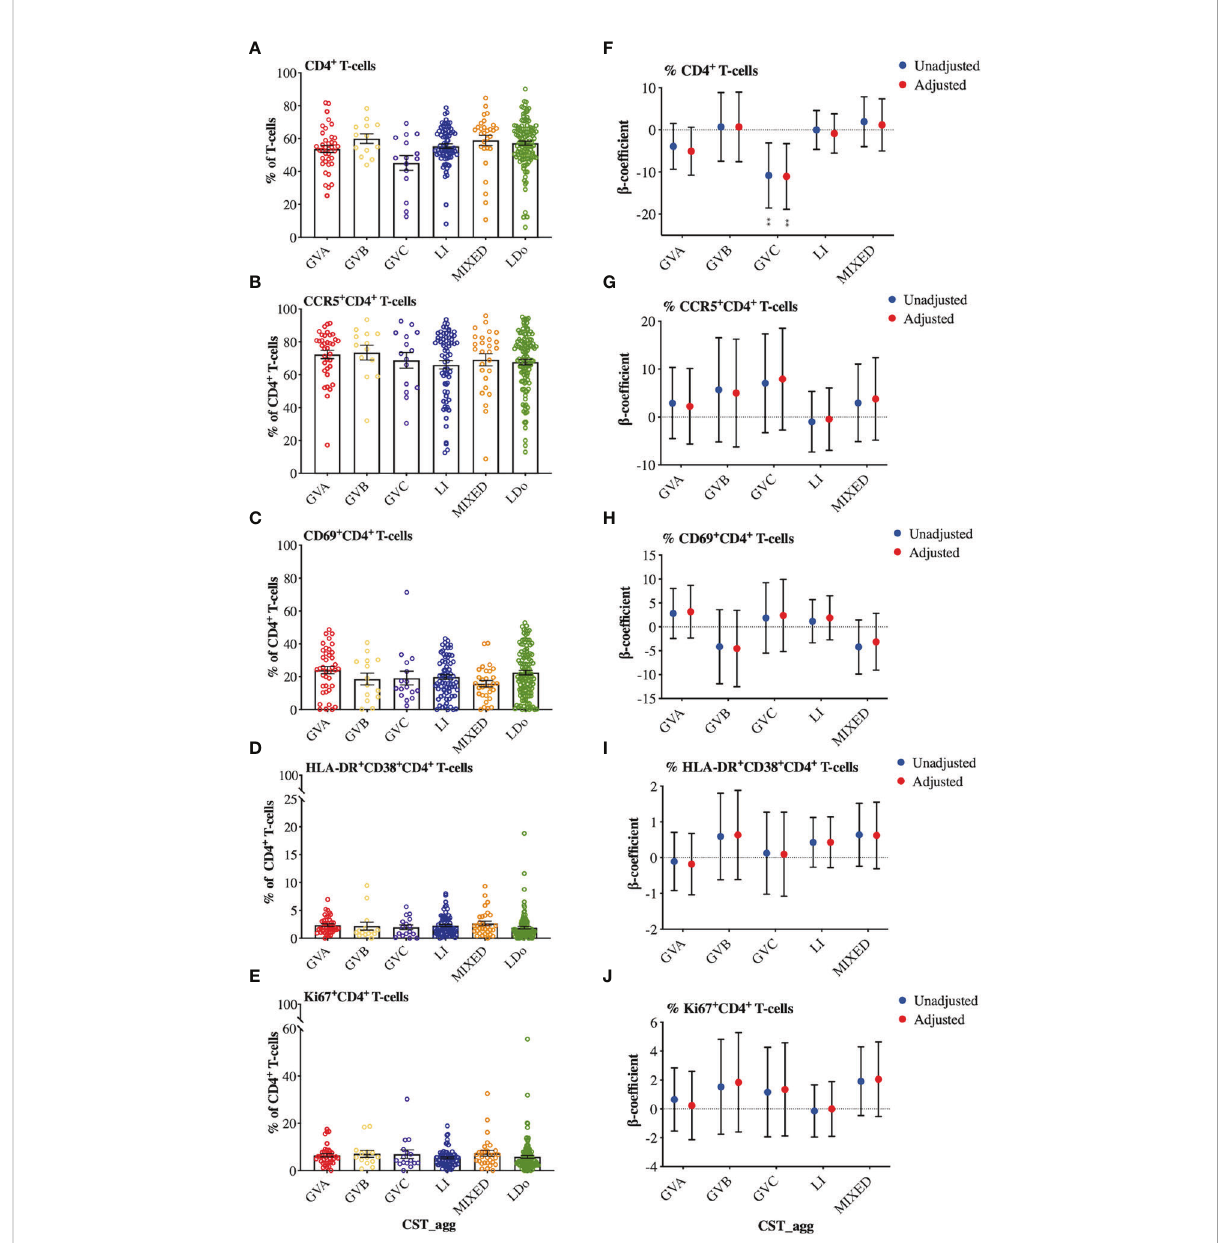
FIGURE 7 Comparison of cellular marker expression on cervical T-lymphocytes among the different cervicovaginal microbial groupings. Raw relative frequencies of (A) CD4 + T-cells expressed as percent of the total T-cells (CD3 + ) and the markers (B) CCR5 (C) CD69 (D) HLA-DR and CD38 (E) Ki67 expressed as percent of total CD4 + T-cells. Linear mixed model analysis of the association between speci fi c cervicovaginal microbial communities (CST_agg) and relative frequencies of (F) CD4 + T-cells expressed as percent of total T-cells (CD3 + ) and the markers (G) CCR5 (H) CD69 (I) HLA-DR and CD38 (J) Ki67 expressed as percent of total CD4 + T-cells. b -coef fi cients represent the mean change in relative frequency of a speci fi c cellular marker that is associated with a speci fi c microbiome (CST_agg) when compared to Lactobacillus (non_iners) dominant (LDo) microbial communities. Blue symbols represent unadjusted models only utilizing microbial groupings as predictors. Red symbols represent models following multivariable adjustment for hormonal contraceptive type, HSV- 2 seropositivity at baseline, concomitant vulvovaginal candidiasis, age, use of BV antibiotics, use of other antibiotics, and use of antifungals prior to sample collection. The error bars in the raw cell count panels represent the standard error of the mean. The error bars from the linear mixed models represent the 95% con fi dence intervals associated with the estimates from the linear mixed models. **P ≤